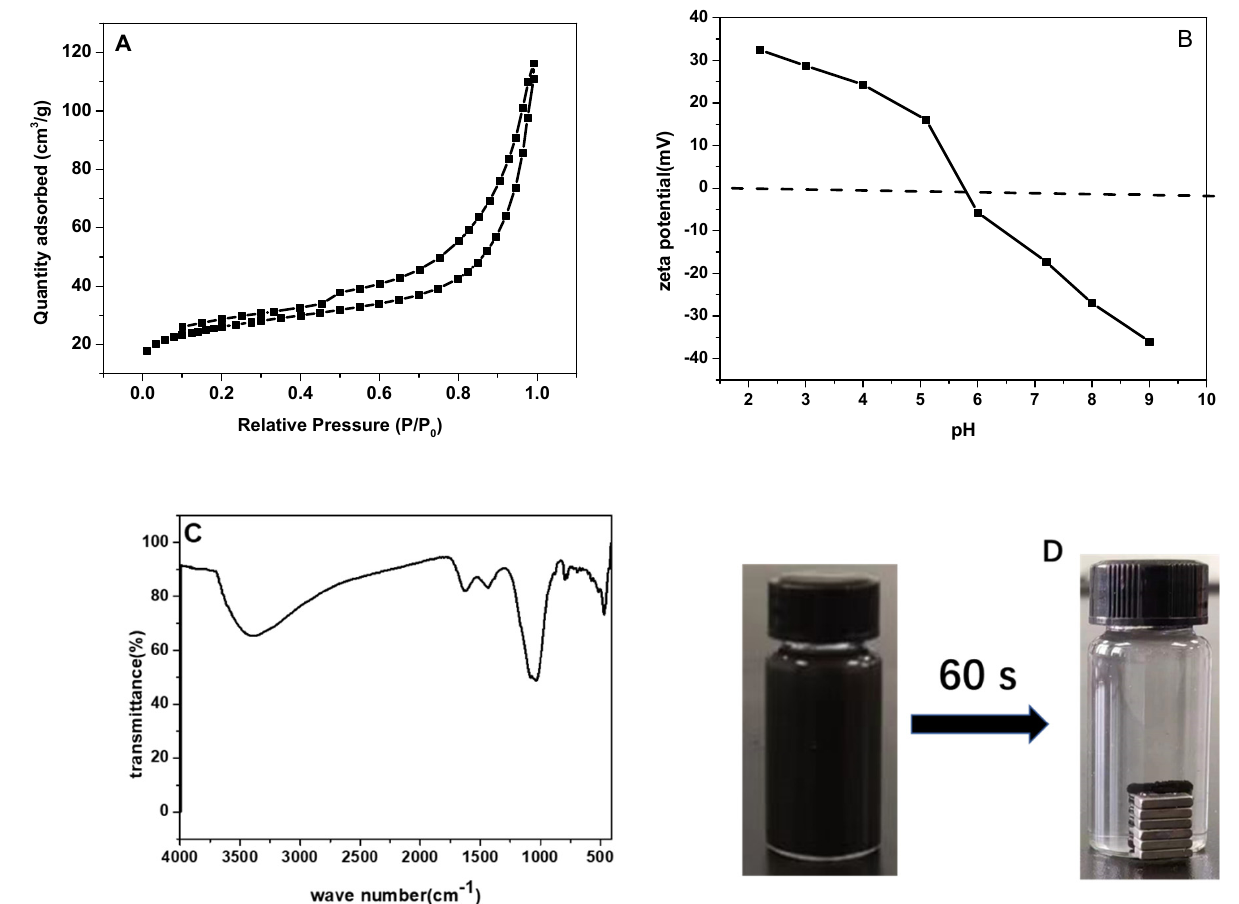
Figure 2. Characterizations of the magnetic biochar ( A ) N 2 adsorption–desorption isotherm, ( B ) Zeta potential, ( C ) FT − IR, and ( D ) magnetic separation property.